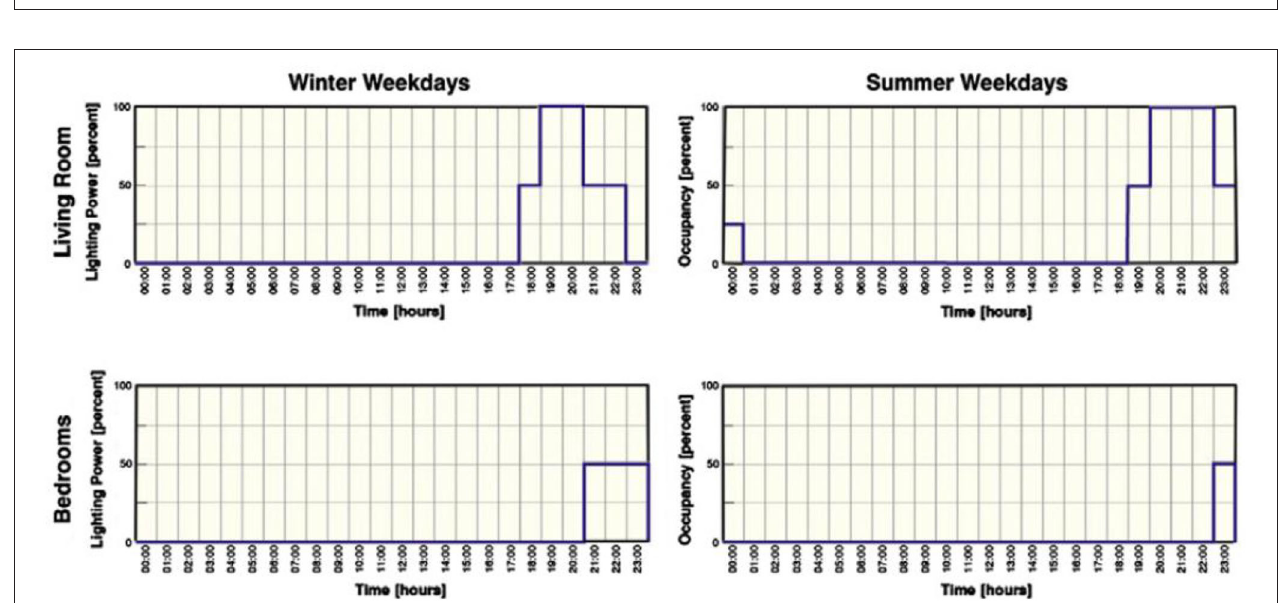
FIGURE 6 | The lighting schedules (average) of the case